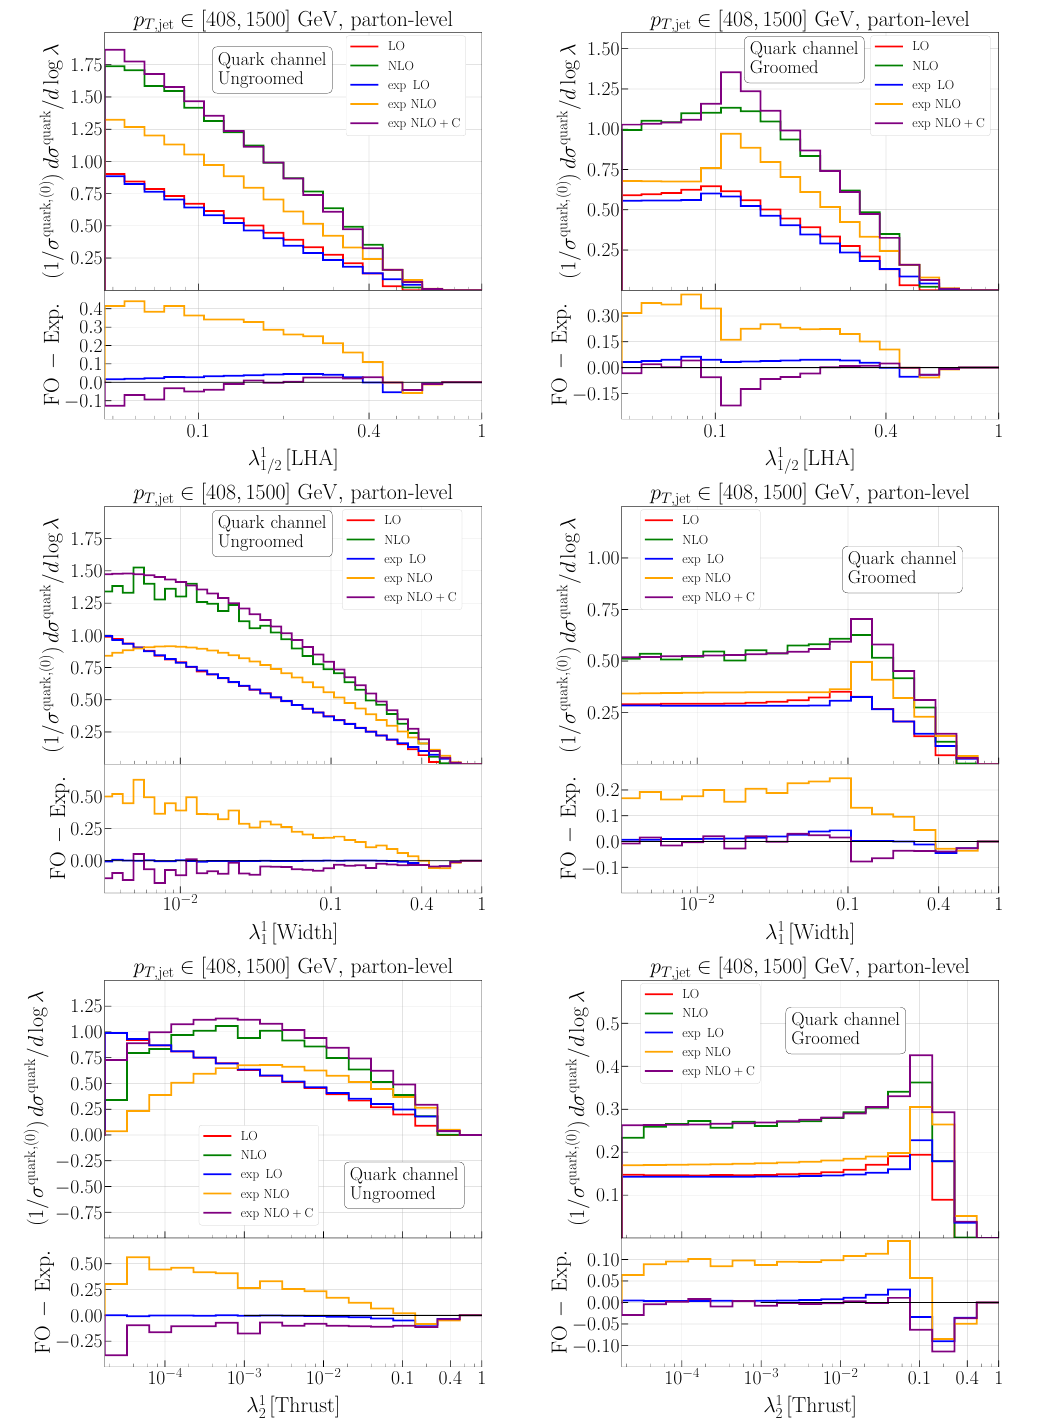
Figure 7 . Fixed-order predictions for the quark channel, identified with the BSZ algorithm, for ungroomed (left column) and groomed (right column) angularities λ 1 to the expansion of the resummation at the corresponding order of α s , see text for details. The jet transverse momentum is constrained to p T, jet ∈ [408 , 1500]